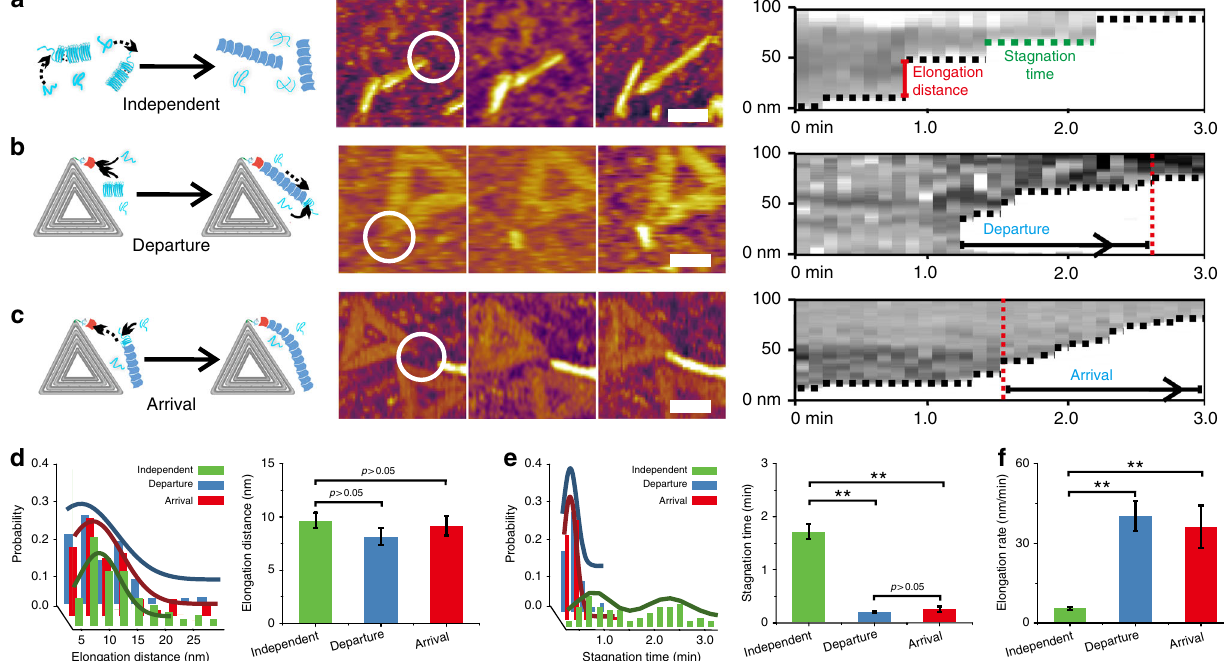
Fig. 4 In situ probing of CsgA polymerization in the presence of CB-origami. a – c Schematic, representative AFM time-lapse images and corresponding kymograph images showing morphological evolution of CsgA fi bril formation either a in the absence of CB-origami (independent mode) or b , c in